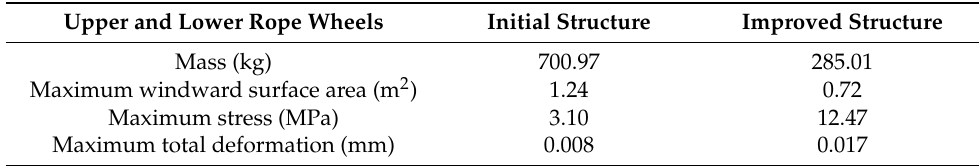
Table 7. Comparison of relevant parameters of upper and lower rope wheels before and after improvement.